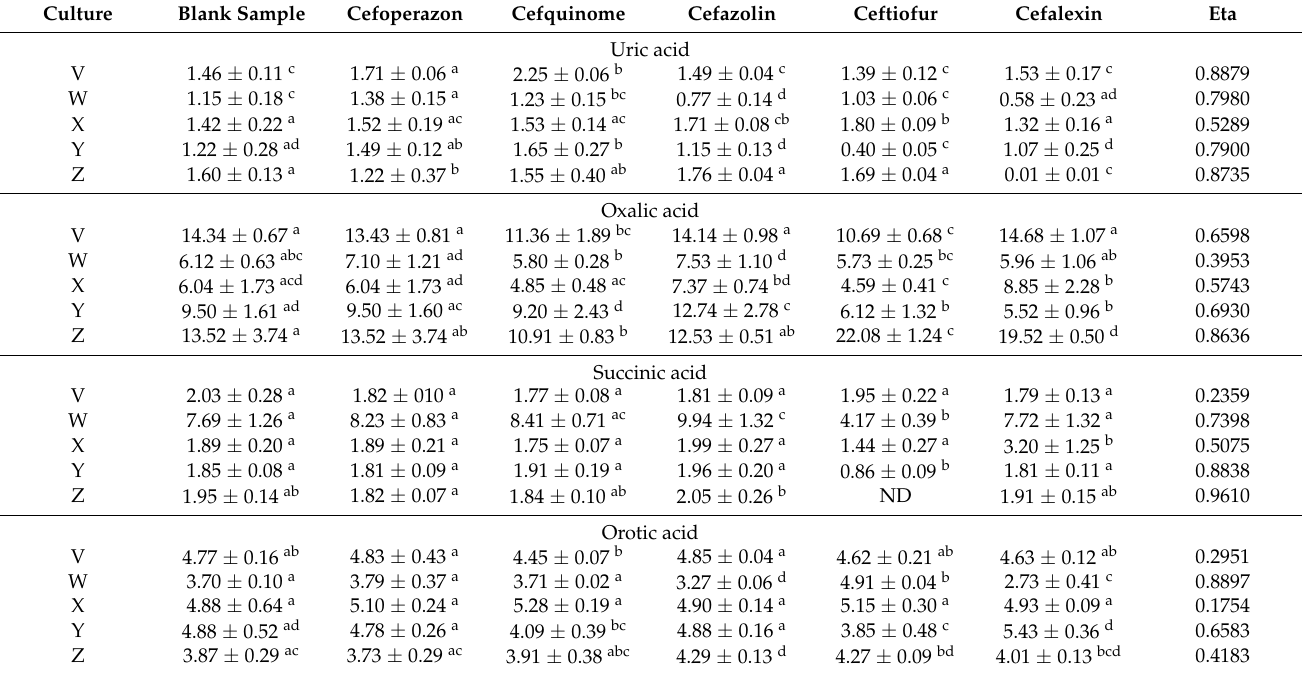
Table 4. Concentration of organic acids at the end of fermentation in samples fortified with cephalosporins and in blank samples (mg 100 g − 1